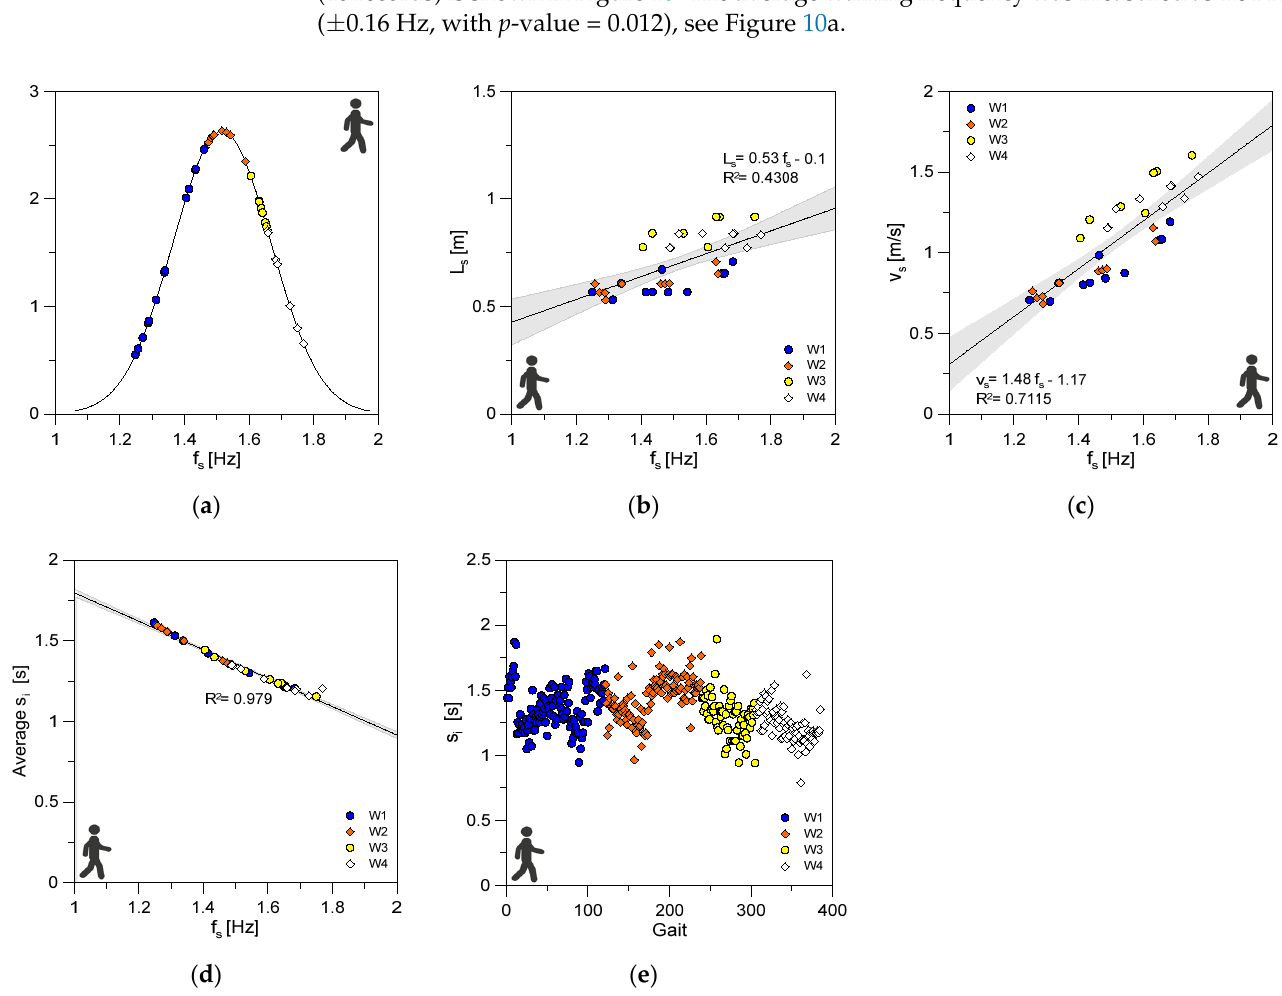
Figure 9. Analysis of experimental body CoM acceleration records (W2–W3 selection) in terms of fast transform magnitude, with evidence of ( a ) vertical, ( b ) transversal, and ( c ) longitudinal components. In this regard, a summary of experimental outcomes for W1-to-W4 configurations (40 records) is shown in Figure 10. The average walking frequency was measured as 1.51 Hz ( ± 0.16 Hz, with p -value = 0.012), see Figure 10a.